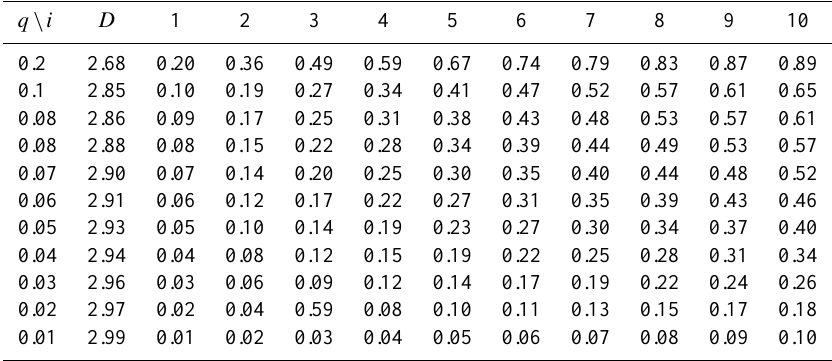
Table 1. Numerical experiments. n = 2. q \ i 1 2